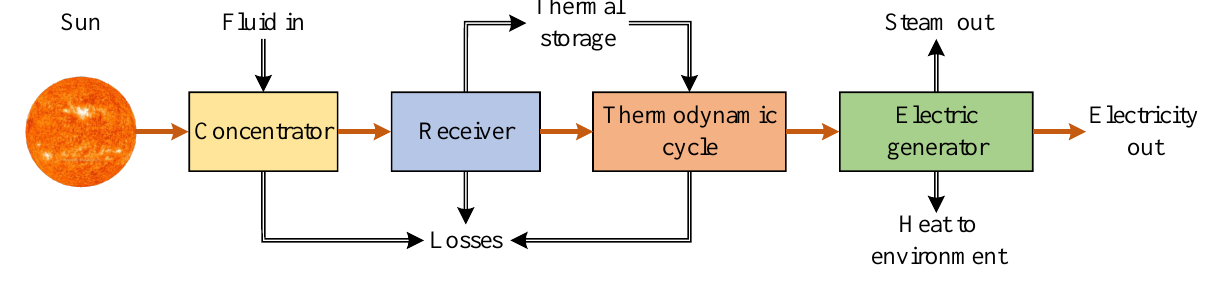
Figure 8. Block diagram of a concentrating solar power plant.